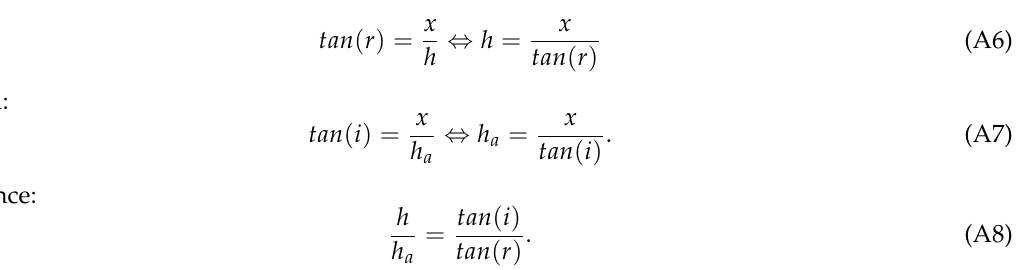
Figure A1. Schematic representation of the refraction of light at the interface between air and water, in terms of the depth ( A ) and apparent depth ( B